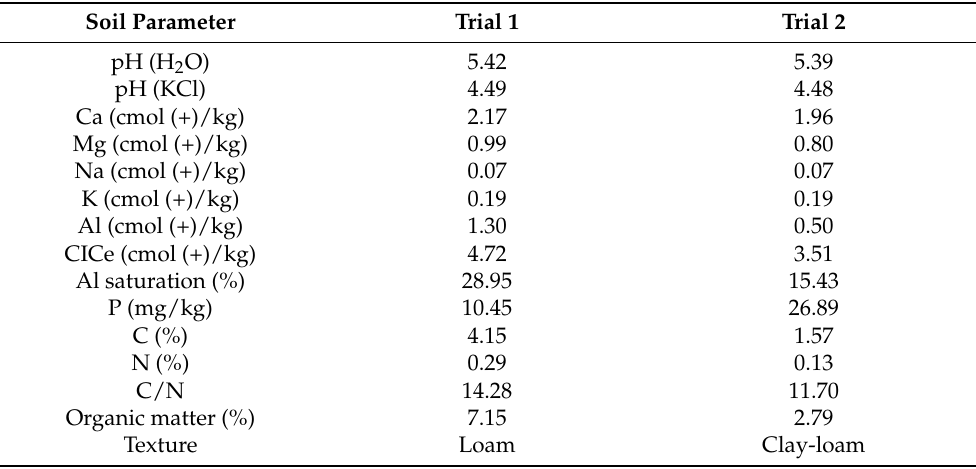
Table 1. Soil parameters of the study sites on the surface horizon of the soil (0–50